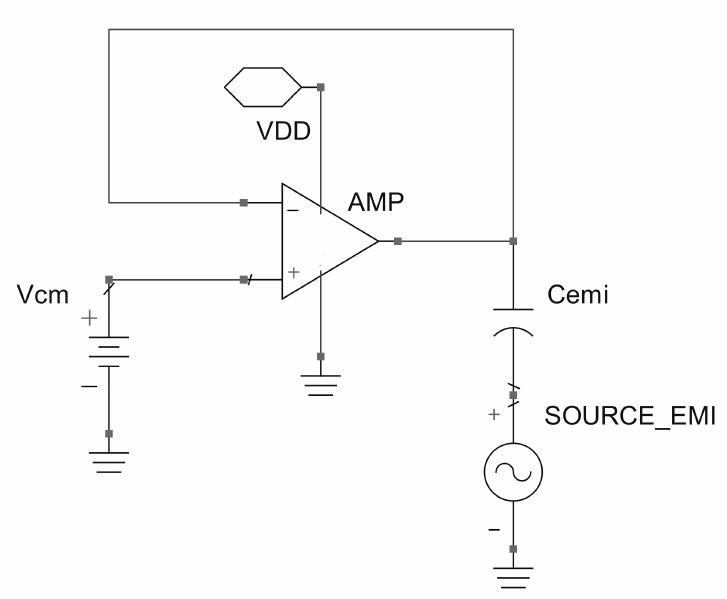
Figure 5. Circuit for the simulations of the EMI effect: EMI coupled to the output